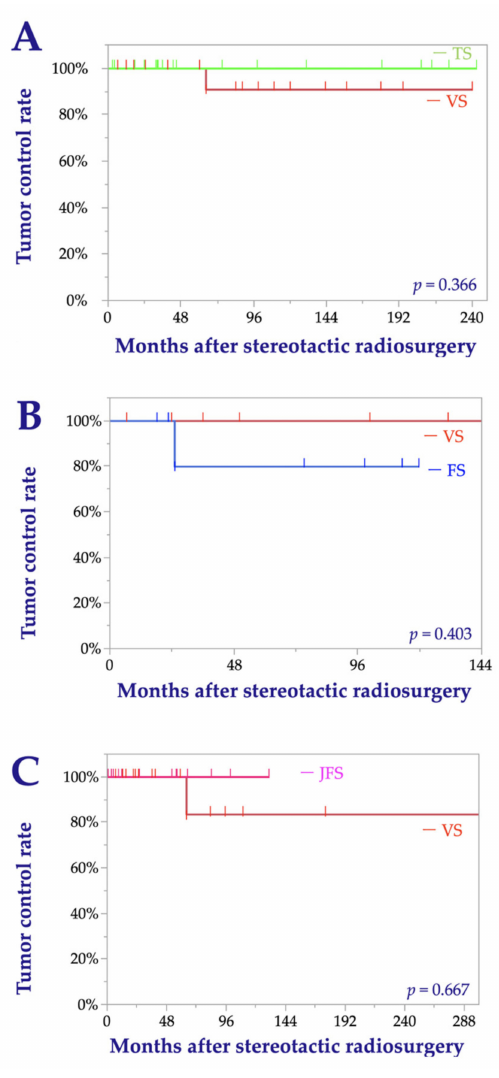
Figure 2. Kaplan–Meier curves for the tumor control rates after matching that compare trigeminal schwannoma (TS) and vestibular schwannoma (VS) ( A ), facial schwannoma (FS) and VS ( B ), and jugular foramen schwannoma (JFS) and VS ( C